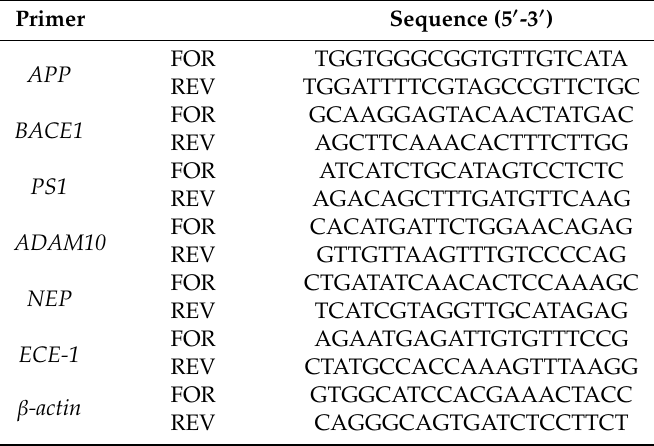
Table 2. Primers used for real-time PCR